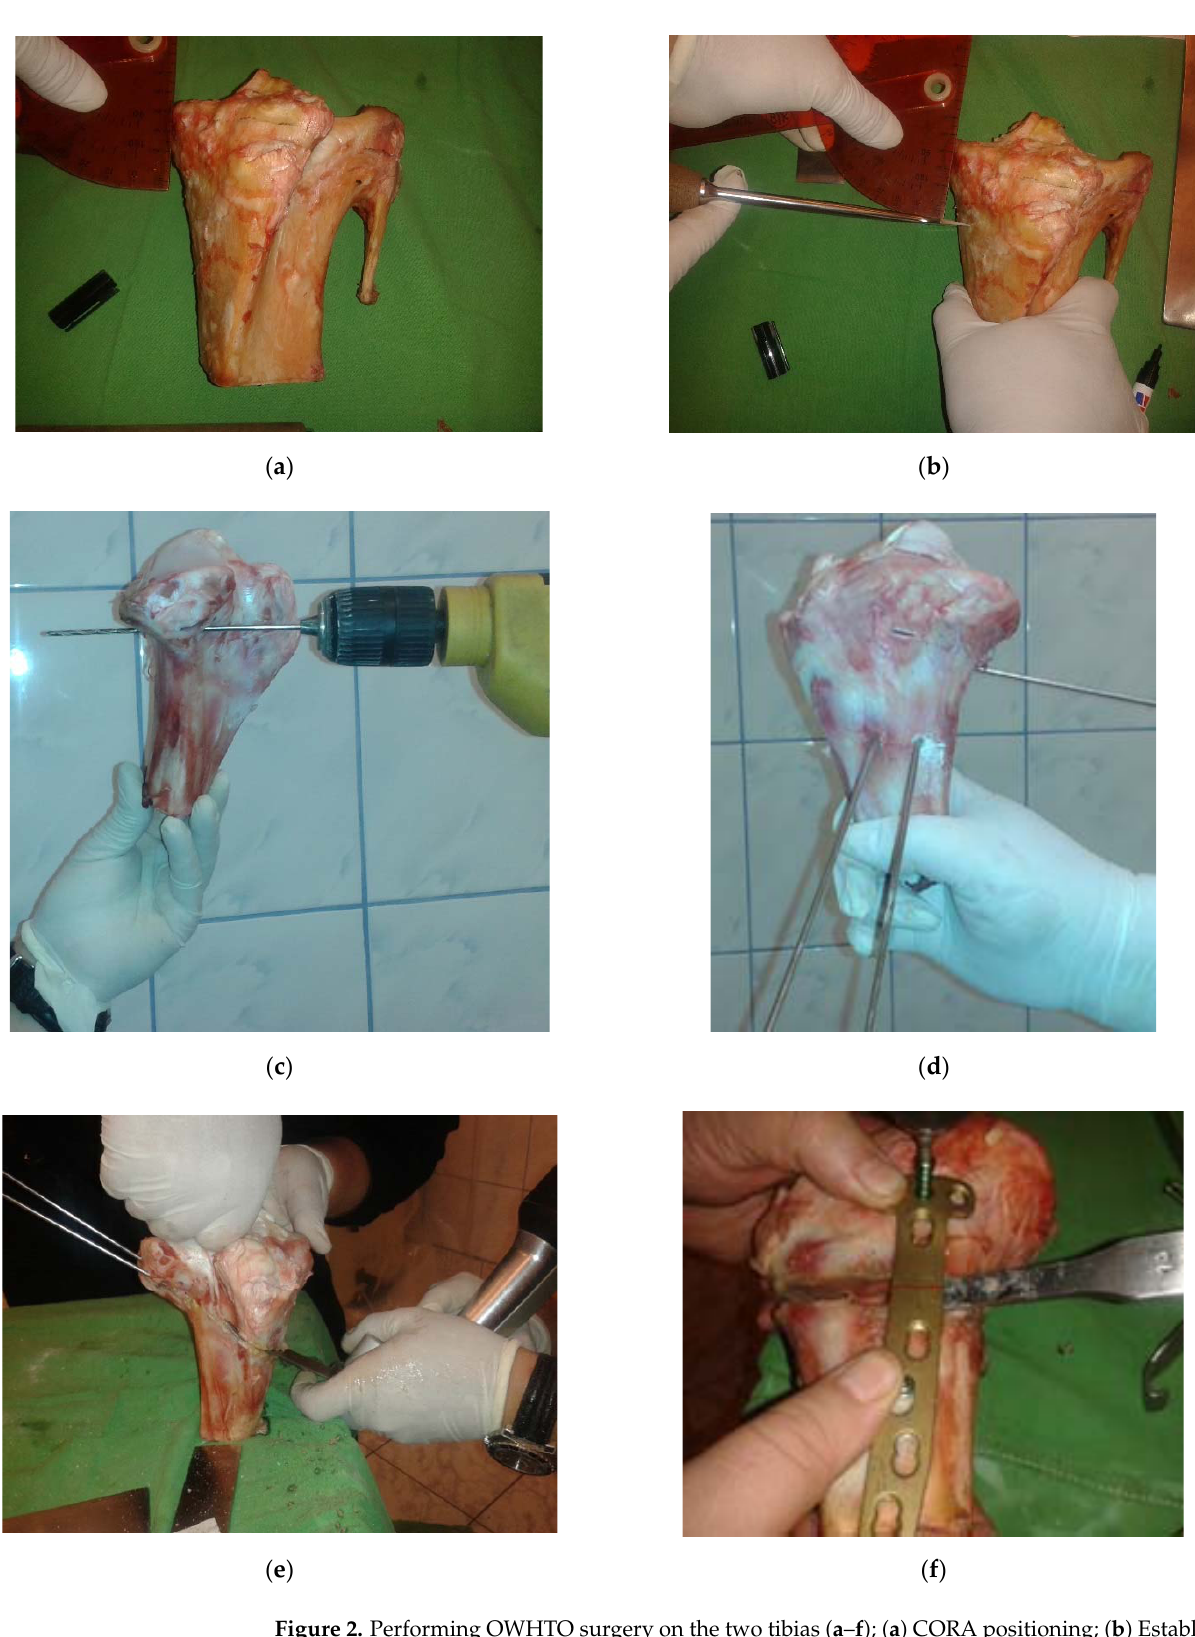
Figure 2. Performing OWHTO surgery on the two tibias ( a – f ); ( a ) CORA positioning; ( b ) Establishing the positions of the initiation point of the cut of the osteotomy plane; ( c ) Drilling the CORA hole; ( d ) Attaching the Kirshner wires; ( e ) Sectioning the osteotomy plane; ( f ) Positioning and mounting the TomoFix plate.